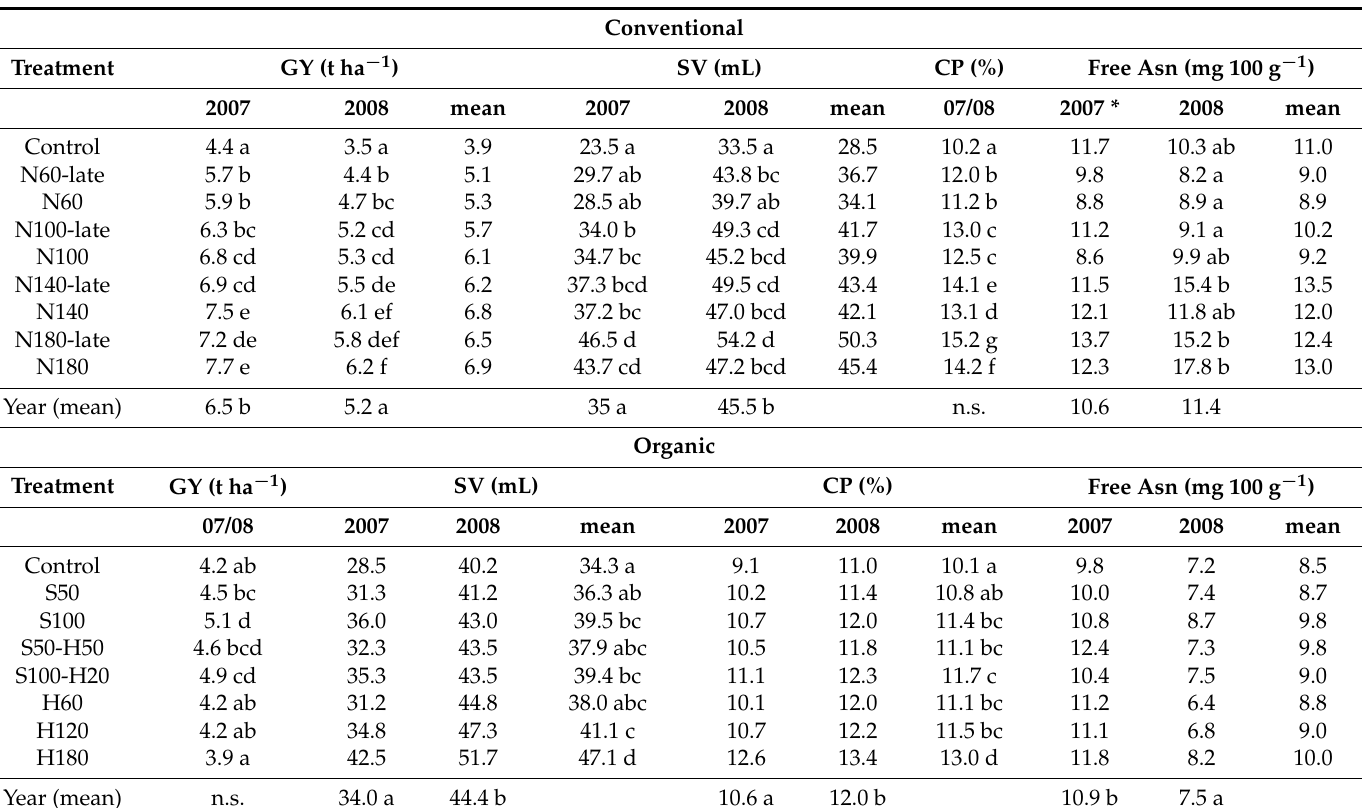
Table 4. Grain yield (GY), sedimentation value (SV), crude protein (CP), and free Asn of the conventional and organic N trial in dependence on fertilization and year for winter wheat cultivar